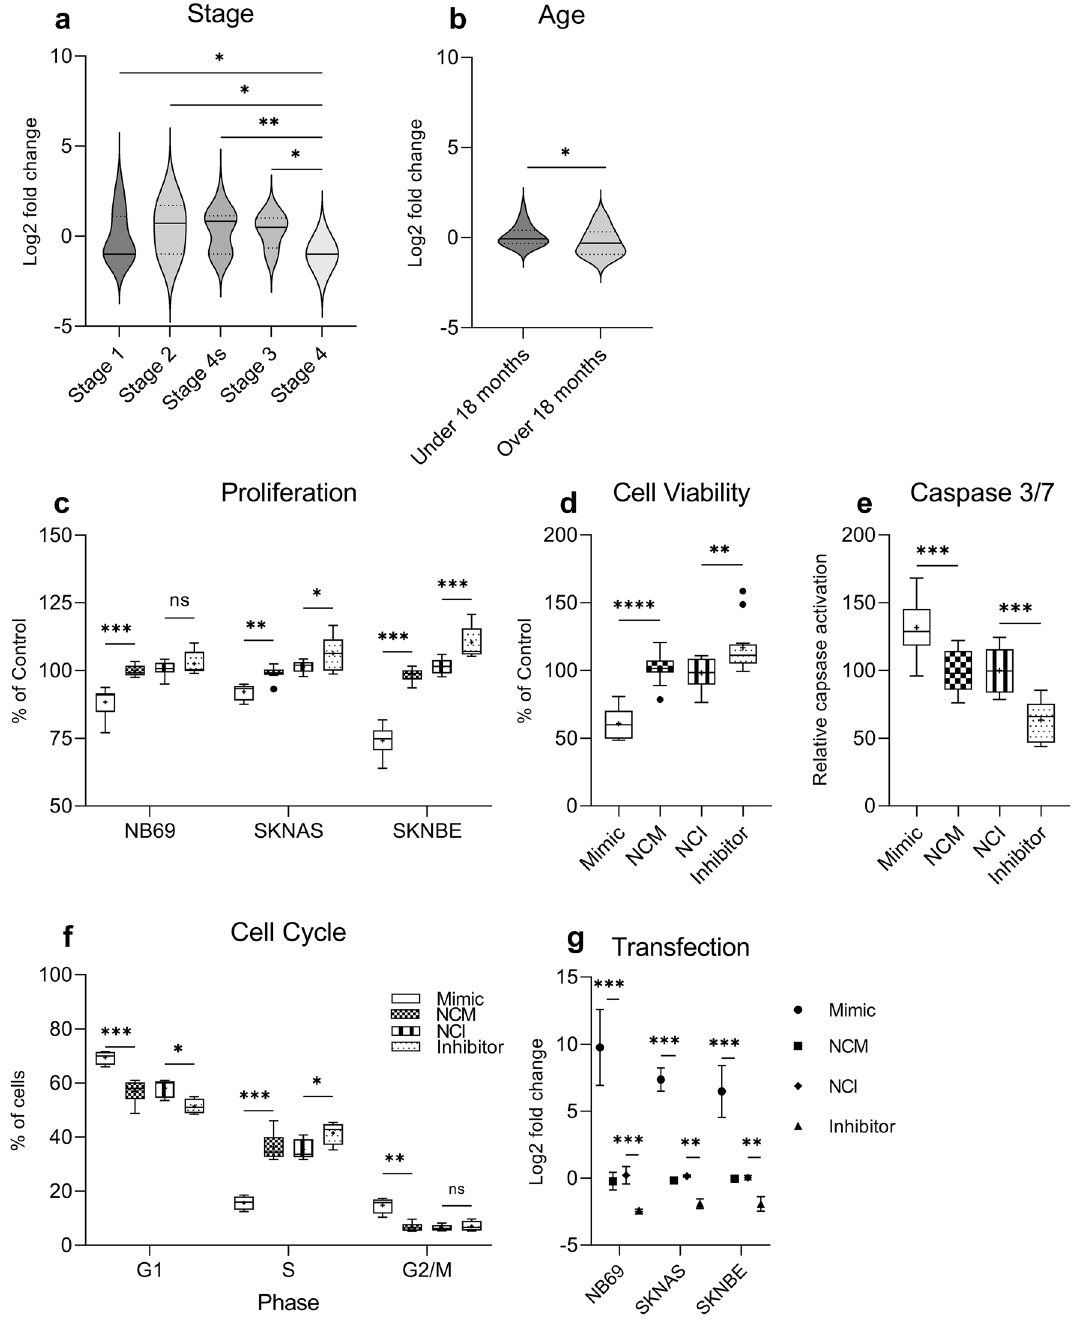
Figure 8. miR-548l expression in NB primary dataset GSE155945 stratified by ( a ) INSS stage and ( b ) age at diagnosis. Violin plots are presented with a slid line at the median and a dashed line showing the quartiles. The effect of miR-548l over expression (mimic) or miR-548l silencing (inhibitor) compared to negative control mimic (NCM) and negative control inhibitor (NCI) was determined in NB69, SKNAS (11q deletion) and SKNBE2 ( MYCN amplified) cell lines regarding ( c ) cell proliferation, ( d ) cell viability ( e ) apoptosis initiation measured by caspase 3/7 activity. ( f ) Cell cycle analysis in response to miR-548I mimic or inhibitor in SKNBE2 cells. ( g ) miR-548l expression in NB69, SKNAS (11q deletion) and SKNBE2 ( MYCN amplified) cell lines after transfection of miR-548l mimic, miR-548l inhibitor, negative control mimic (NCM) and negative control inhibitor (NCI). Boxplots are presented with a line at the median, and ‘ + ’ at the mean. The whiskers represent the 10th to 90th percentiles (Tukeys). The expression and protein data are presented as log2 fold change and plotted as a scatter plot with a line at the mean. Statistical significance was determined by one-way ANOVA with a Holm-Šídák’s multiple comparisons test for groups of 3 or more or a paired t-test for exactly 2 groups. * p < 0.05, ** p < 0.01, *** p < 0.001, ****p < 0.0001, ns = not